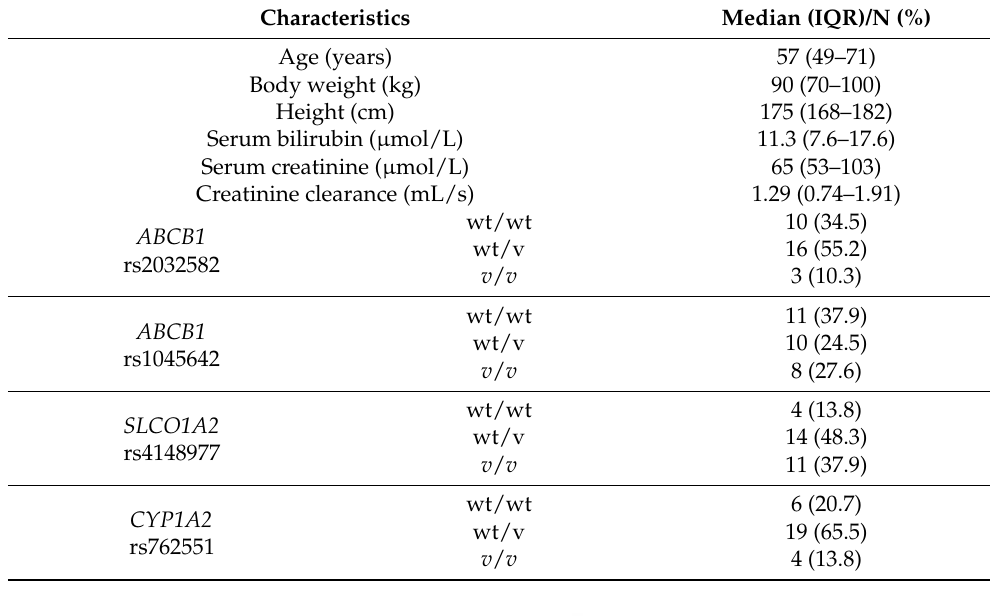
Table 2. Patient characteristics and genotype frequencies of ABCB1 (rs2032582 and rs1045642),